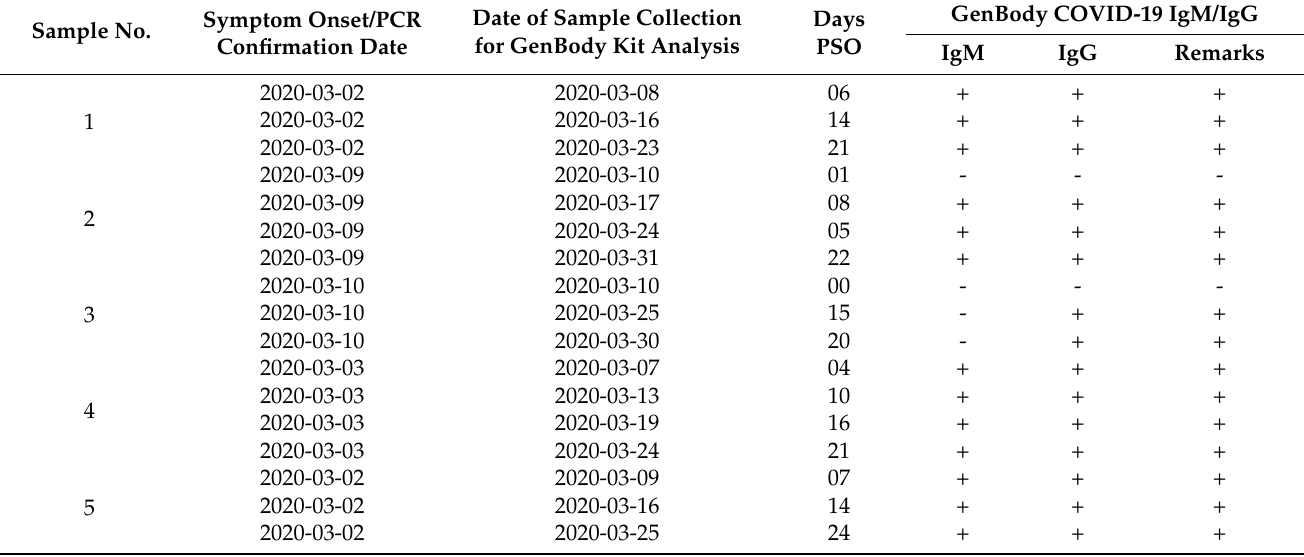
Table 6. Seroconversion pattern based on the detection through GenBody COVID-19 kit. Sample